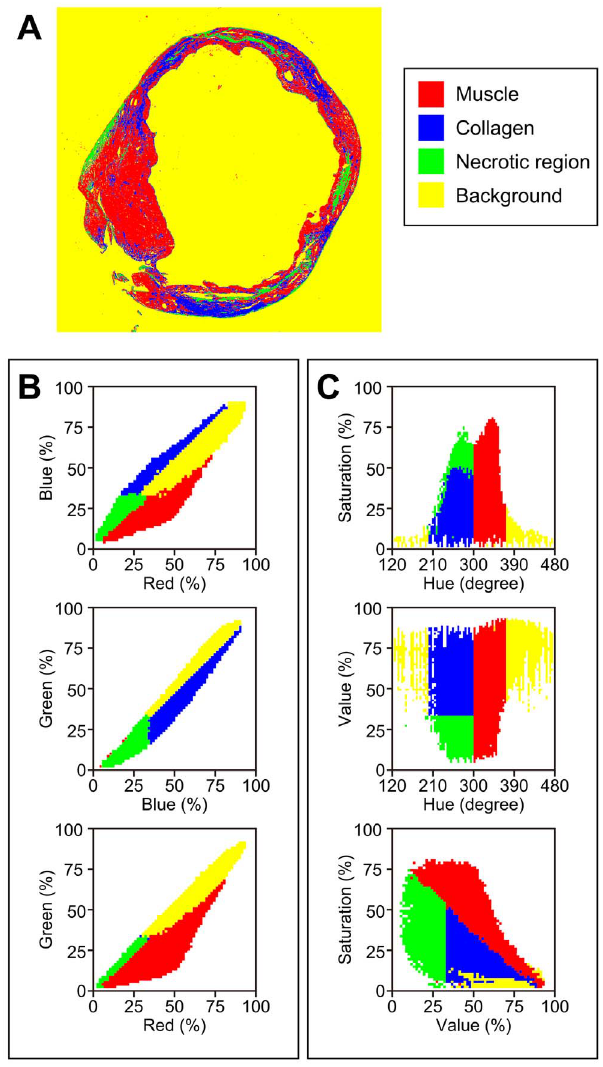
Figure 3. Additional thresholds are possible with CSH . An infarcted mouse heart, analyzed by CSH for collagen, muscle, and necrotic tissue. A) A post-processed image of an infarcted mouse heart using the HSV method that includes a binary for necrotic tissue. B) 2-D plots of the original pixels mapped to the RGB color space, but with the same binary applied as in Figure 3A. C) 2-D plots of the original pixels mapped to the HSV color space. doi:10.1371/journal.pone.0089627.g003 parameters for each method using a single image, then left those parameters constant for all subsequent analyses. The RGB analysis method returned inconsistently diverse areas, which were identi- fied as collagen vs. muscle as section thickness changed (Figure 2D).